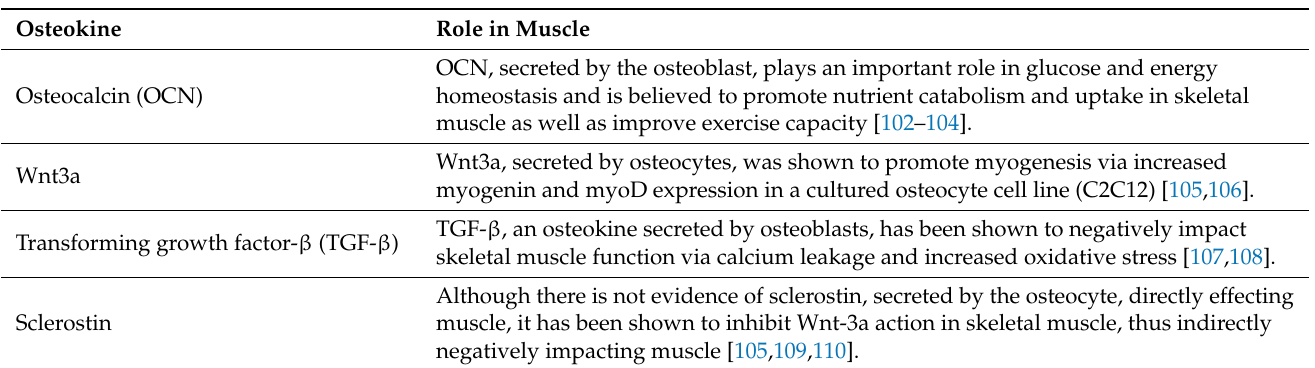
Table 2. Osteokines and their roles in